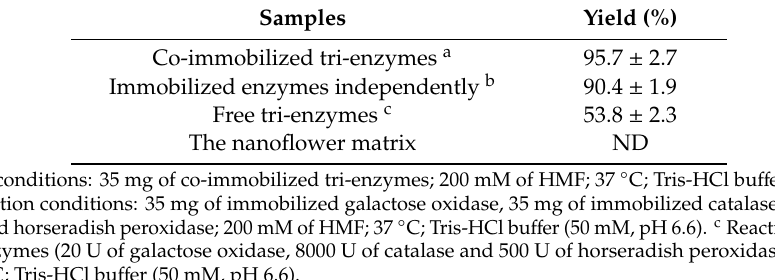
Table 4. Comparison of the DFF yield of co-immobilized enzymes and independently immobilized enzymes.